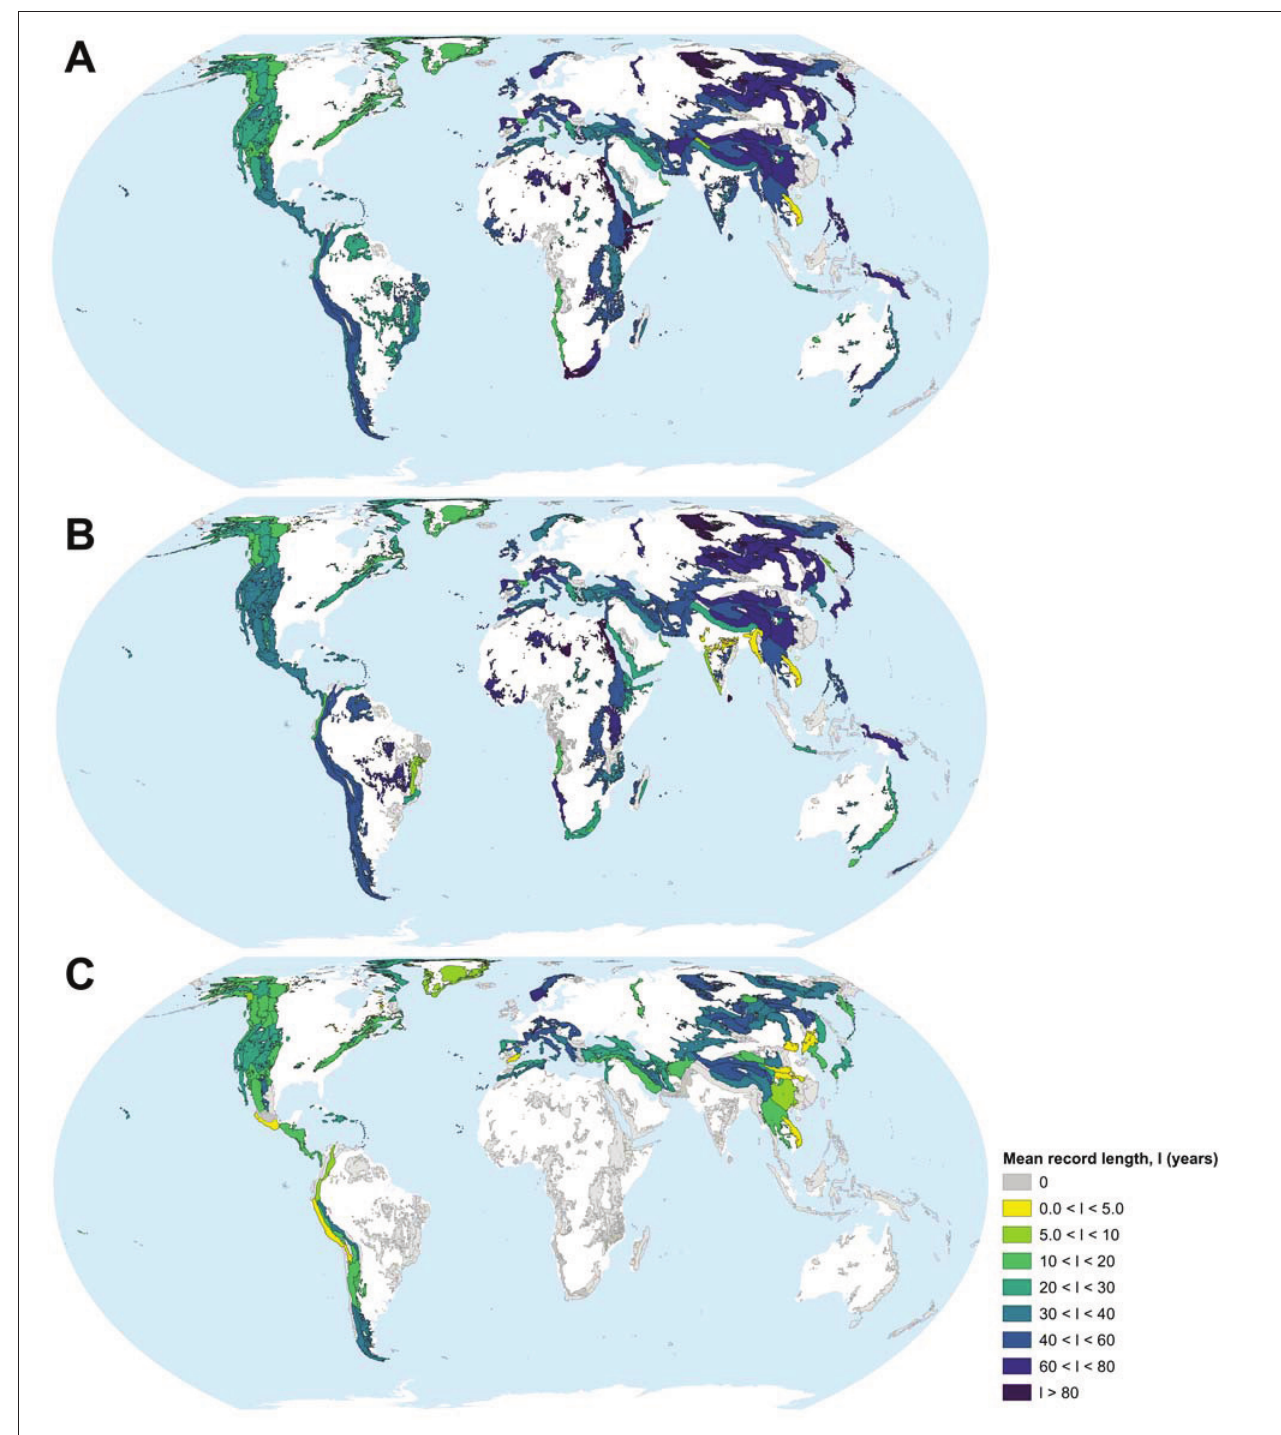
FIGURE 4 | Mean approximate record length of GHCNd stations in mountainous terrain for PRCP (A) , TMAX (B) , and SNWD (C) by GMBA mountain polygon. The corresponding plot for TMIN is provided in the online Supplementary Material. Whilst the entire GMBA regions are shown, the statistics plotted correspond to only the mountainous parts of these regions, as delineated by Kapos et al.